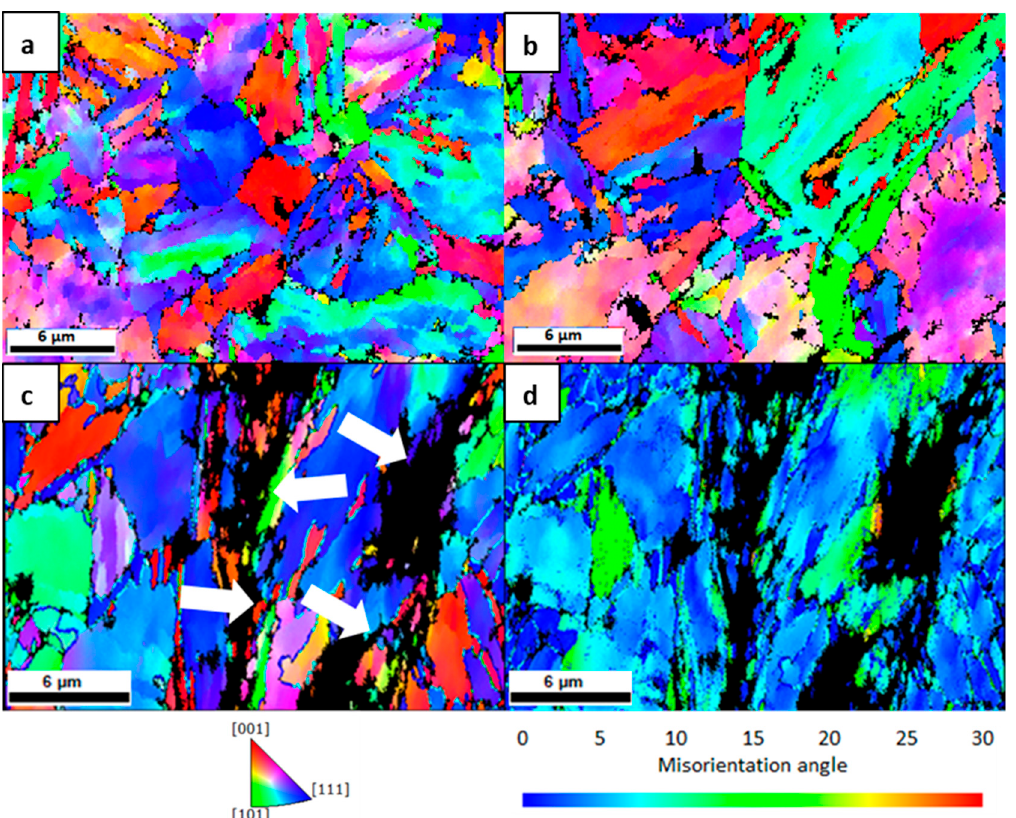
Figure 9. Inverse Pole Figure maps in the normal direction of the ( a ) uncharged, ( b ) 3 h pre-charged, ( c ) 6 h pre-charged CP steel samples near the fracture and ( d ) misorientation map of 6 h pre-charged CP steel